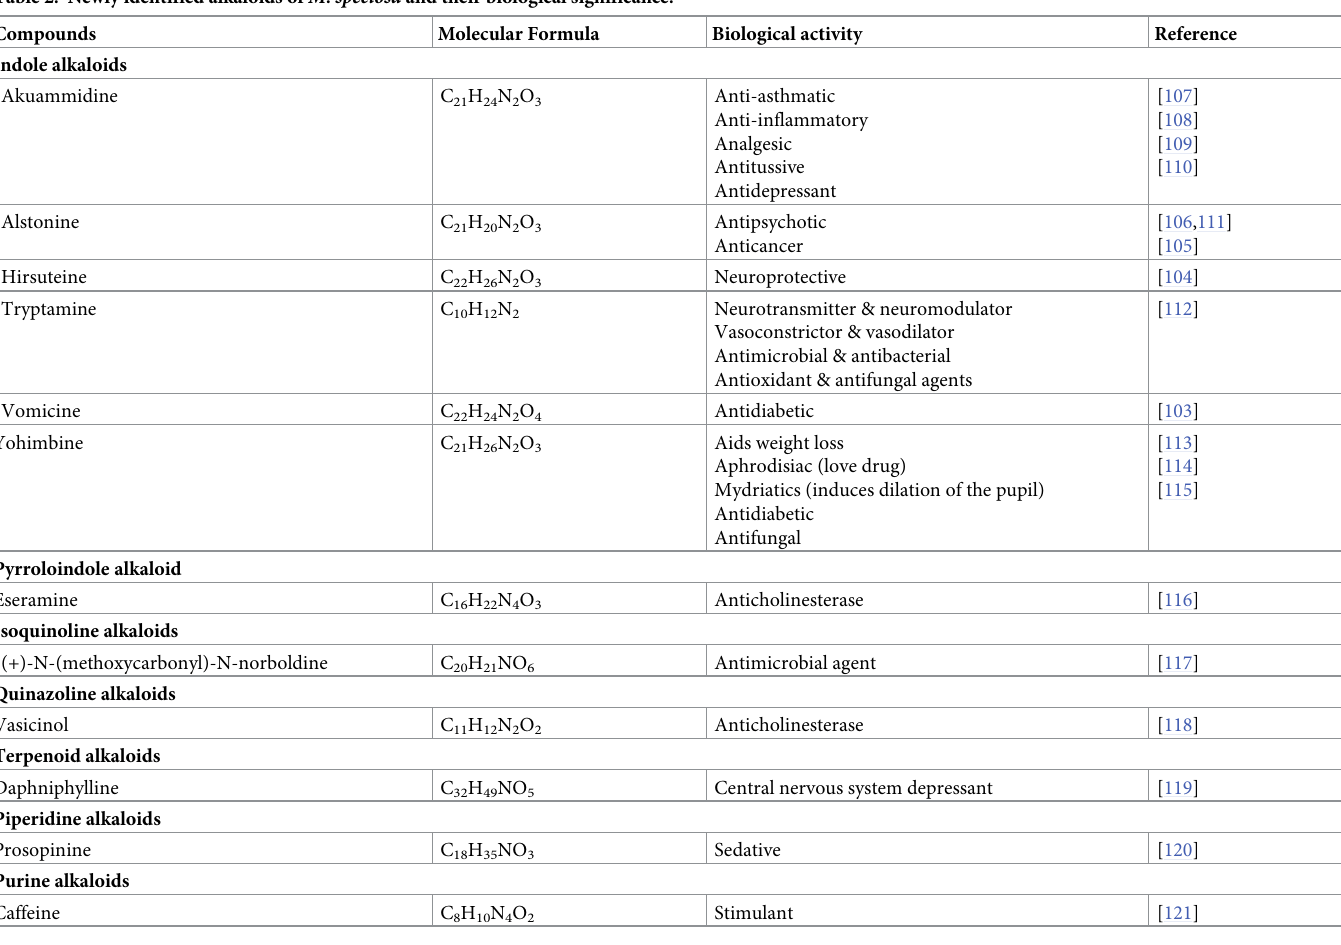
Asterisks ( � ) indicate highly differential metabolites (FDR < 0.05, |Log 2 FC| >